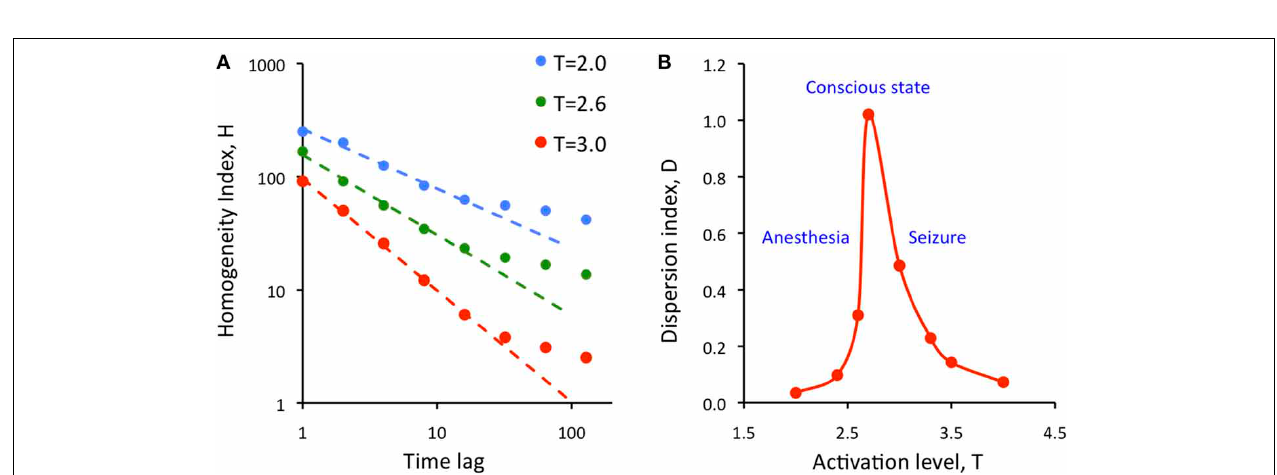
FIGURE 7 | Dependence of the state repertoire on cortical activation level and embedding time lag. (A) Homogeneity index, H decreases as a function of the time lag of according to power law up to a lag of 20. Decreasing the activation level T (anesthesia) decreases the